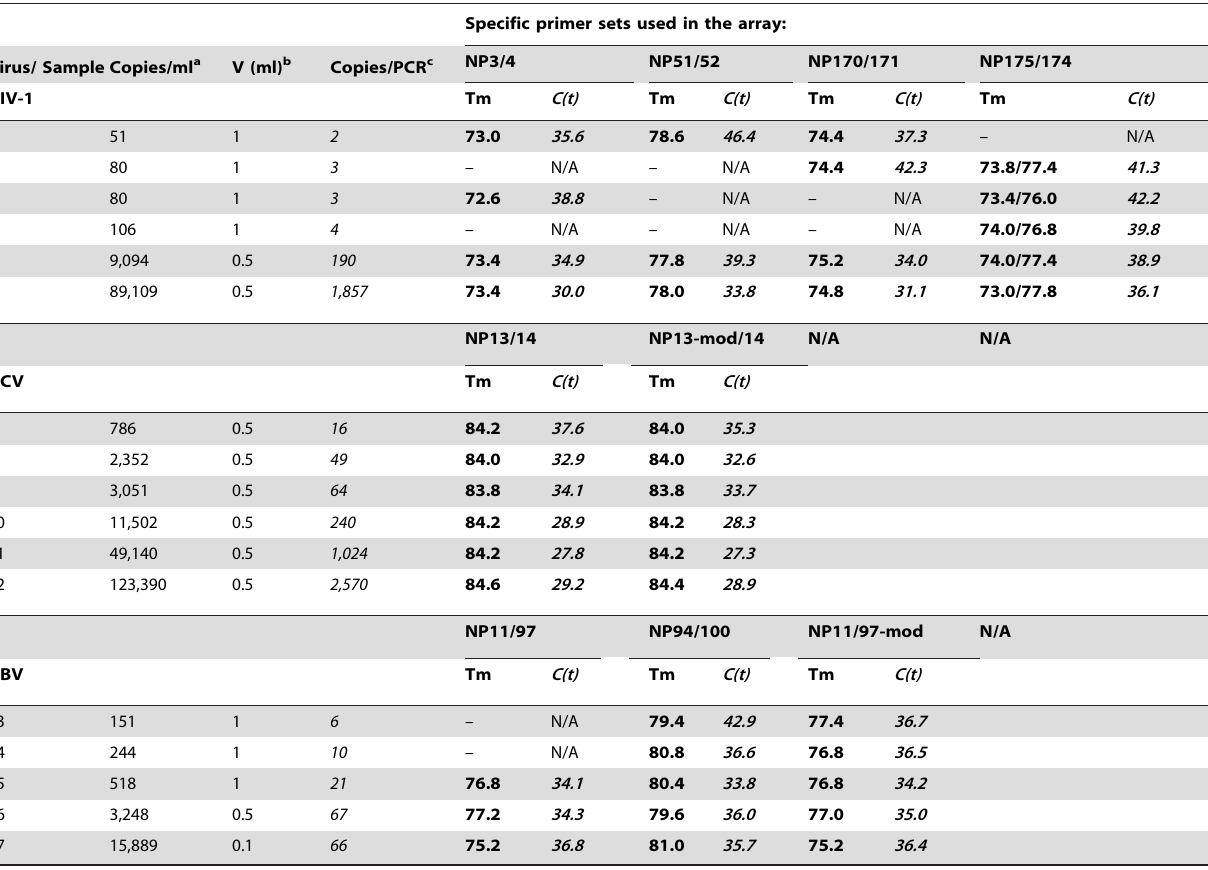
Specific primer sets used in the